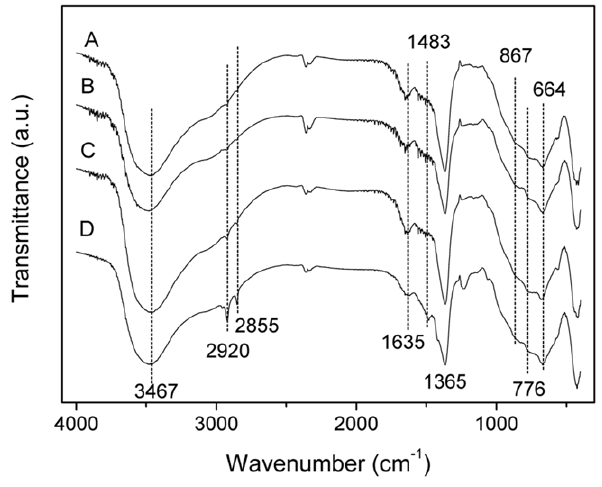
Figure 3. IR spectra of the synthesized LDHs. A: S-Ni 0.1 MgAl, B: S- Ni 0.1 MgAl-Nd, C: S-Ni 0.1 MgAl-Ce and D: S-Ni 0.1 MgAl-La.